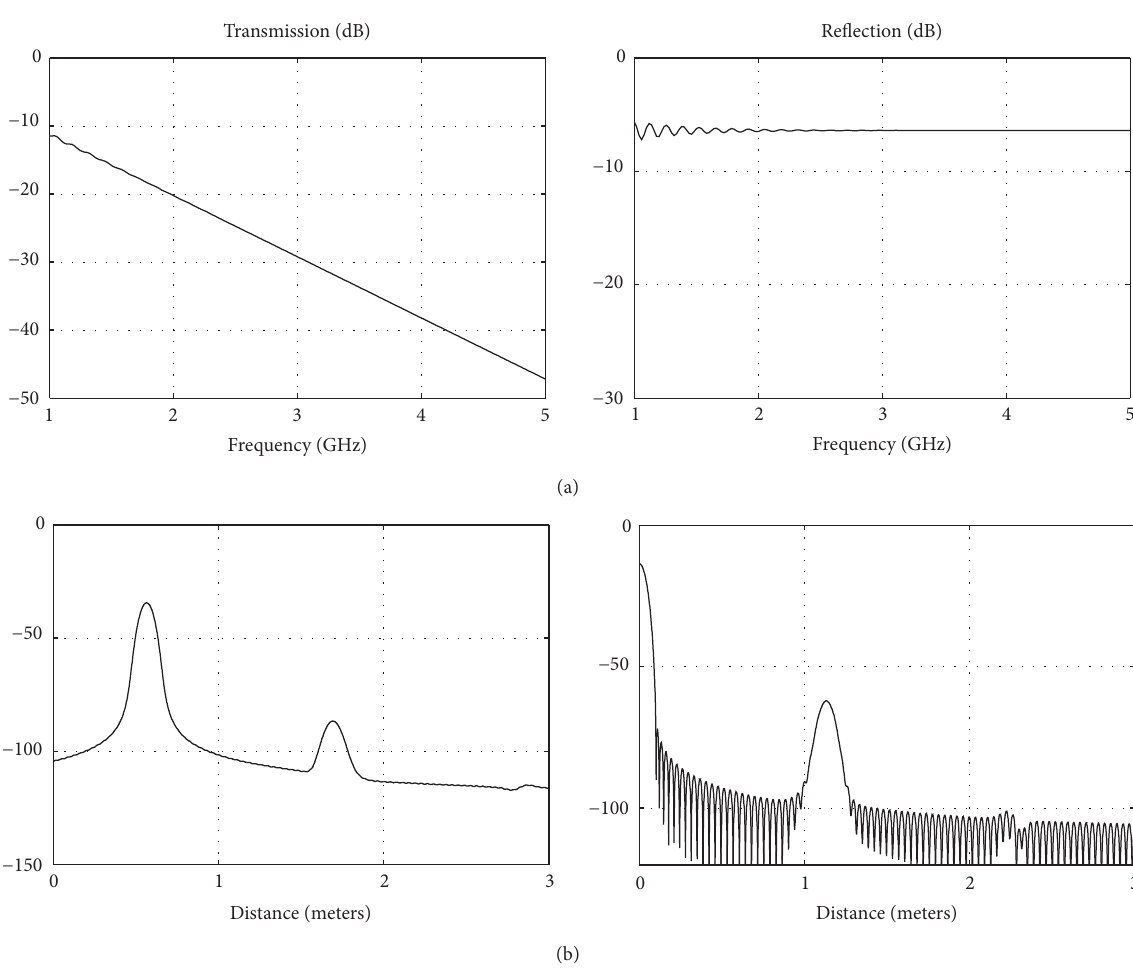
F 2: 2�cm solid concrete transmission and re�ection coefficient in fre�uency domain (a) and in time domain (b).